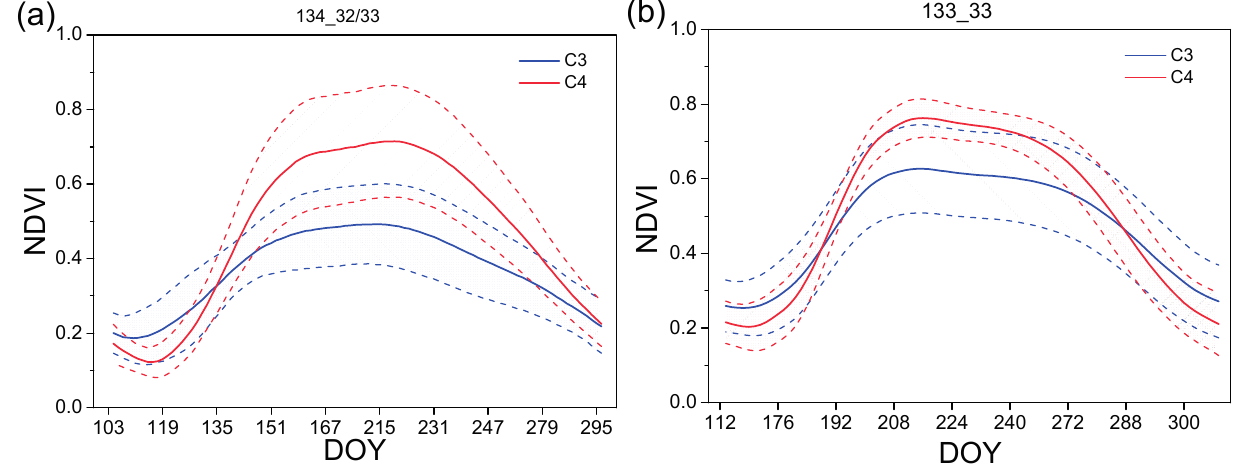
Figure 5. Time-series NDVI profile plotted according to field investigation points. Shaded areas indicate the variance of the C3 and C4 NDVI. ( a ) time-series NDVI profile of 134_32/33 sub-area; ( b ) time-series NDVI profile of 133_33